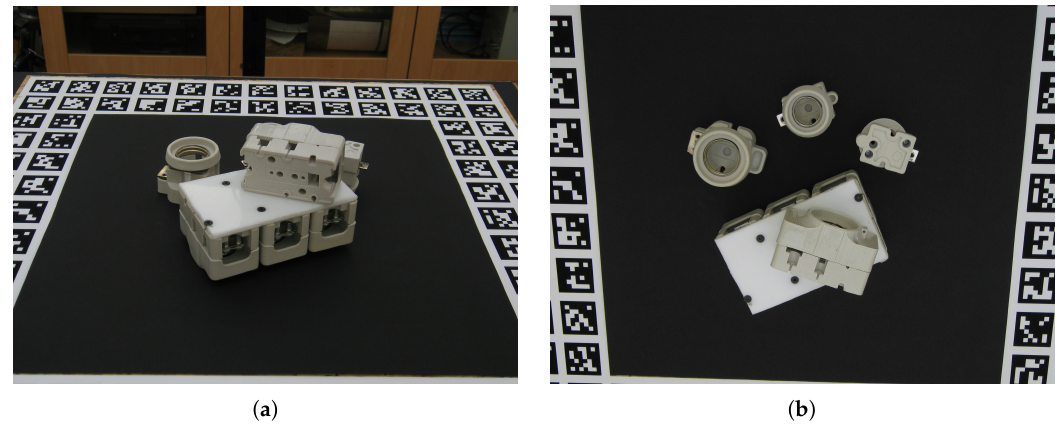
Figure 9. ( a ) Side view perspective and ( b ) top view perspective on TLess